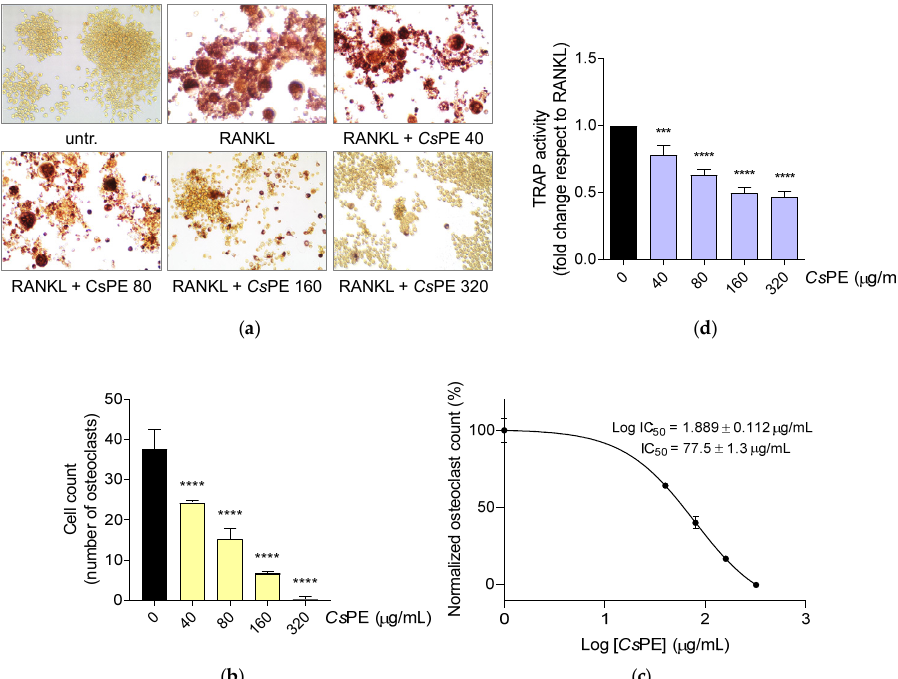
Figure 6. Suppression of osteoclast differentiation by CsPE in RAW 264.7 cultured with RANKL. ( a ) Representative staining of TRAP-positive osteoclasts, induced by RANKL from RAW 264.7 macrophages in the presence of the indicated concentrations of CsPE; untr, RAW 264.7 cells cultured without RANKL and left untreated. Osteoclasts are TRAP-positive purple–pink multinucleated cells having three or more nuclei. ( b ) Quantitative analysis of osteoclasts represented as TRAP-positive multinucleated cell number in RANKL-differentiated control (black bar) and CsPE/RANKL-treated samples (yellow bars). Results are reported as mean ± SD of the osteoclasts’ number counted in randomly selected visual fields in different areas of each well. Only TRAP-positive purple–pink cells with three or more nuclei were considered osteoclasts. ( c ) A concentration-response curve was obtained to determine the IC 50 of CsPE. The IC 50 value was determined using a non-linear regression analysis. ( d ) Quantitative analysis of TRAP activity in the culture supernatant, represented as fold change in CsPE/RANKL-treated samples (violet bars) with respect to RAW 264.7/RANKL control (black bar) and reported as the mean ± SD of three independent experiments, each conducted in triplicate. *** p < 0.001, **** p < 0.0001, CsPE/RANKL-treated versus RANKL-differentiated control (one-way ANOVA test).